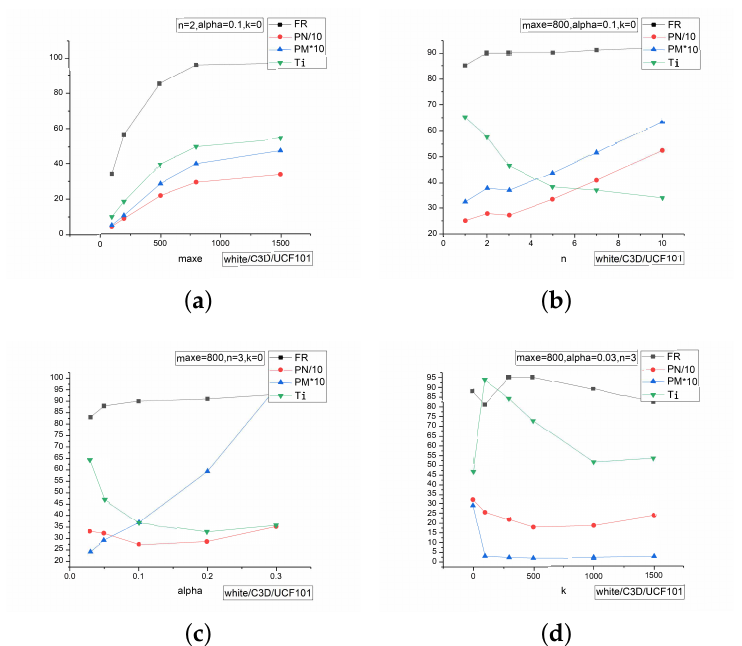
Figure 3. The result of different parameters. In order to keep uniform all metrics and keep the segment of x -axis consistent, we set PN/10 and PM*10. PN is the number of perturbed pixels and PM is short for MAP. All the performances are tested in white-box setting, C3D model with UCF101 dataset. ( a ) performances of different maxe ; ( b ) performances of different n ; ( c ) performances of different ℵ ; ( d ) performances of different k .